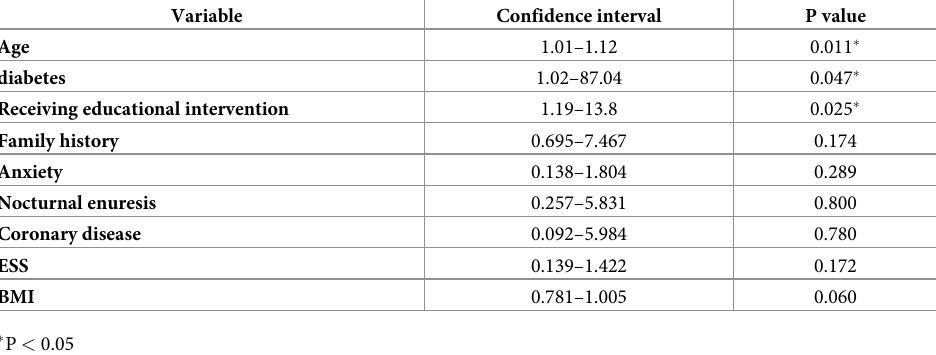
Table 3. Multivariate logistic regression analysis results of the correlation between potential influential factors and sleep test